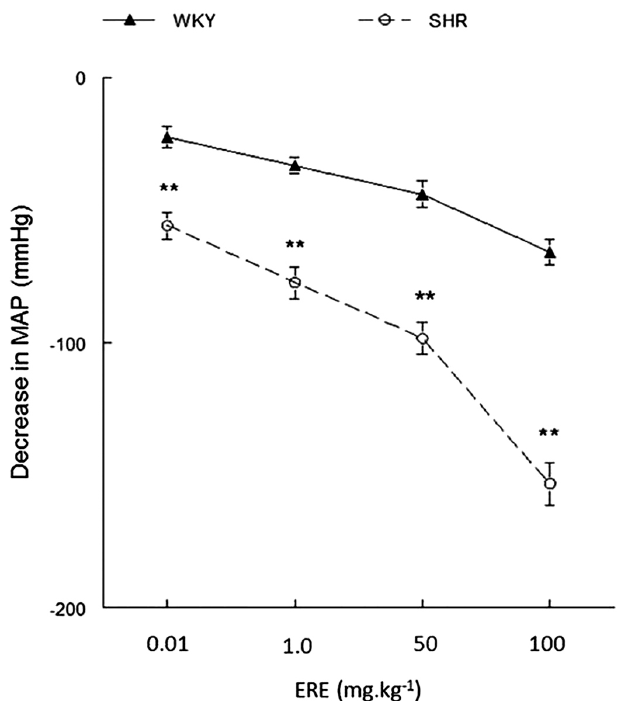
FIGURE 1 - ERE-induced dose-dependent reduction in Mean Arterial Pressure (MAP) in normotensive (WKY) and hypertensive (SHR) animals. ERE: ethanolic extract of Rhynchospora exaltata . The values are presented as the mean ± S.E.M. ** p<0.01 compared WKY.